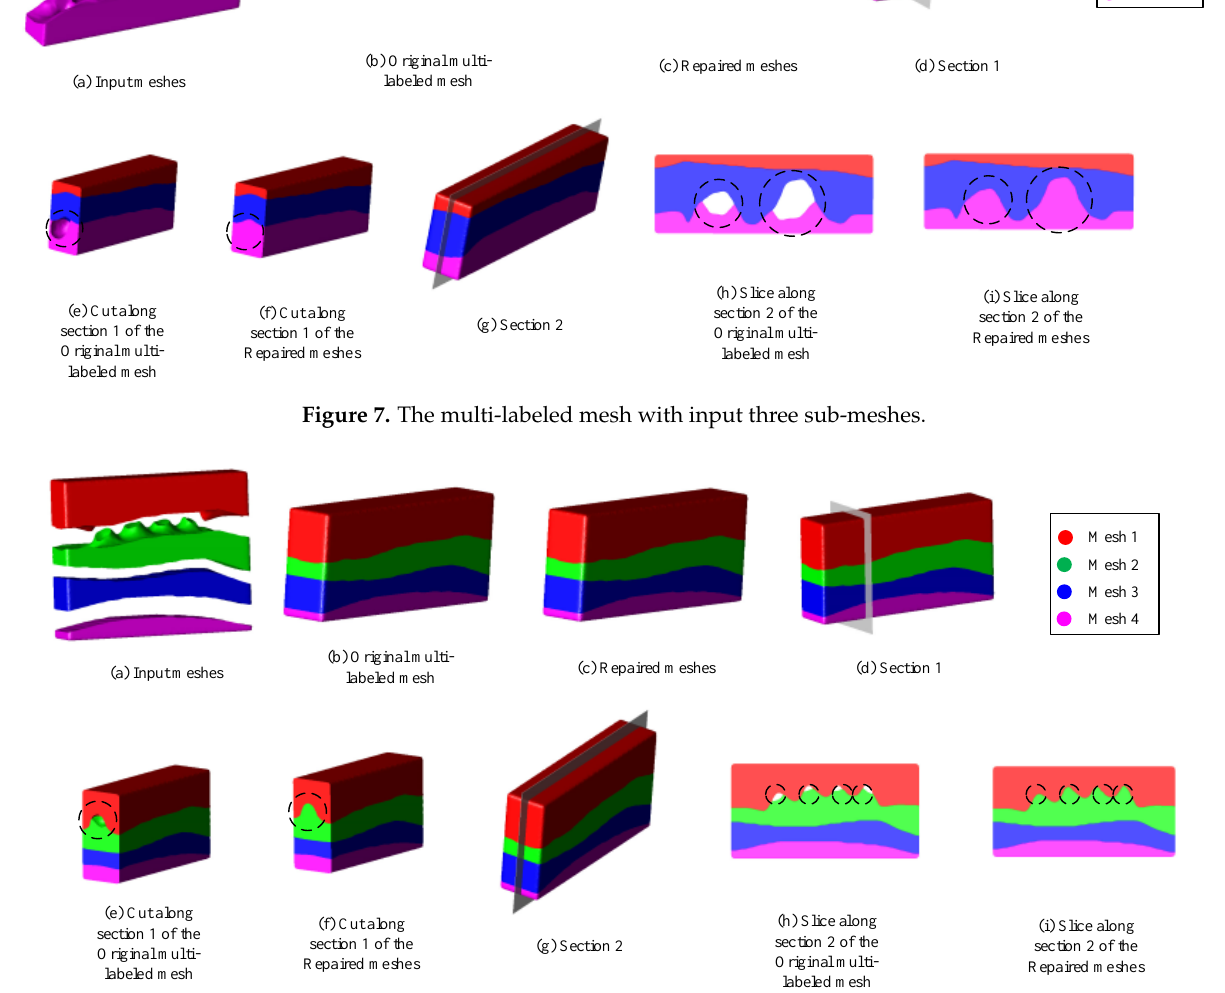
Table 2. Parameters of the multi-labeled mesh with input three sub-meshes. 𝑵 𝑽 is the number of